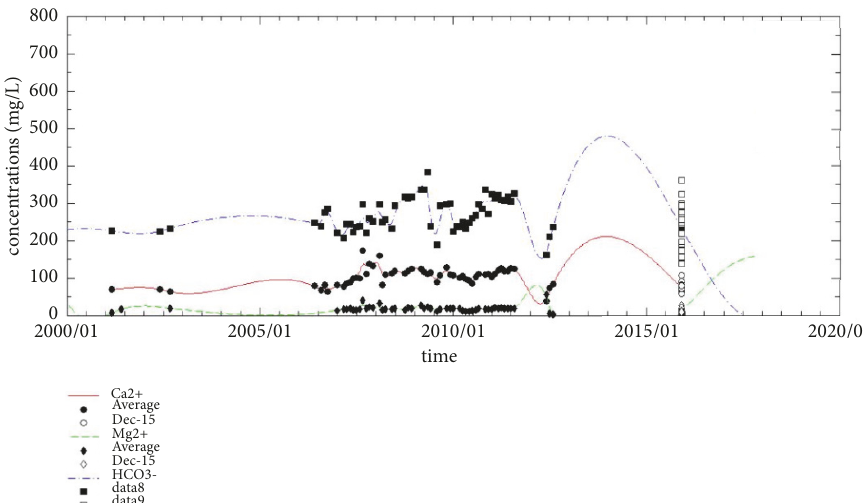
Figure 7: The fitting curves of the means of Ca 2+ , HCO 3− , and Mg 2+ , and the data points of the December 2015 sampling results.